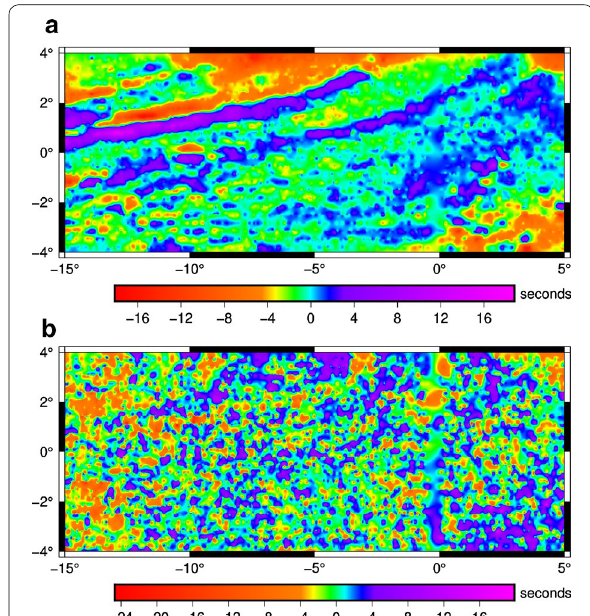
Fig. 5 Vertical deflections derived from HY-2A data: a North component; b East component